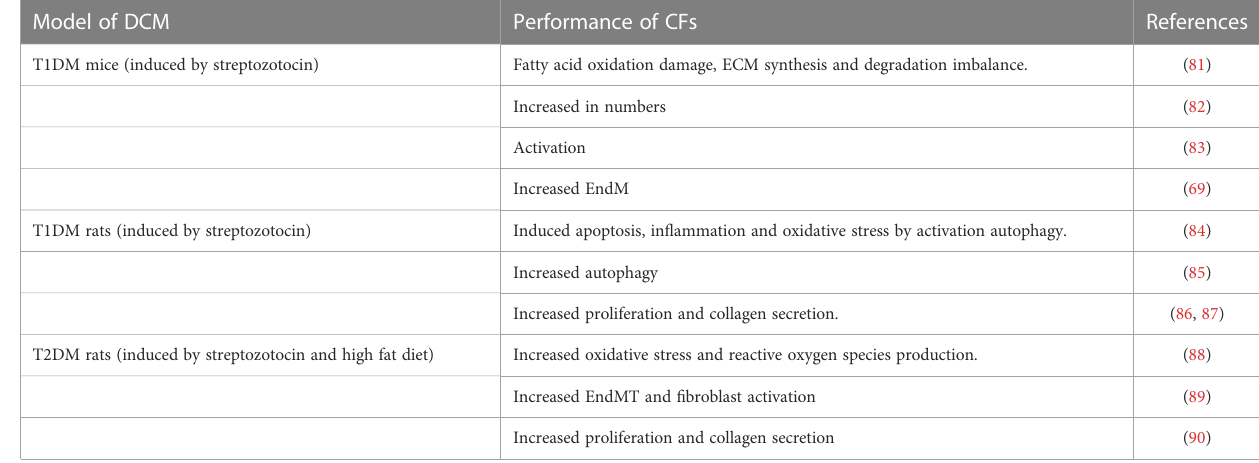
TABLE 1 Association between diabetic cardiomyopathy (DCM) and cardiac fi broblasts (CFs). Model of